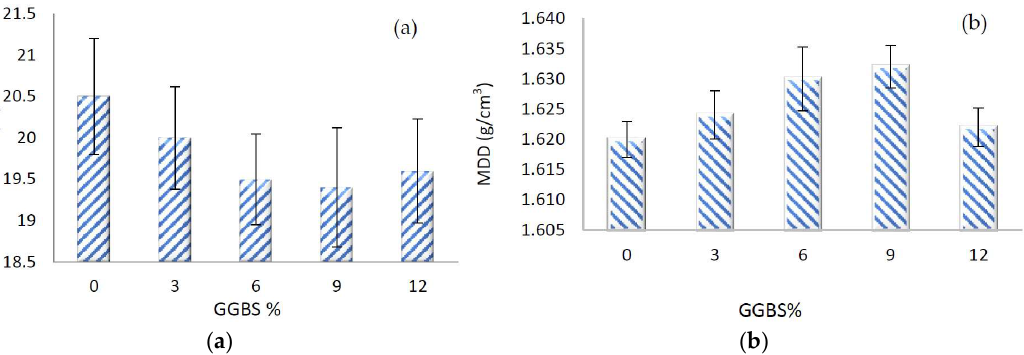
Figure 2. ( a ) OMC of soil with different GGBS contents; ( b ) MDD of soil with different GGBS contents.